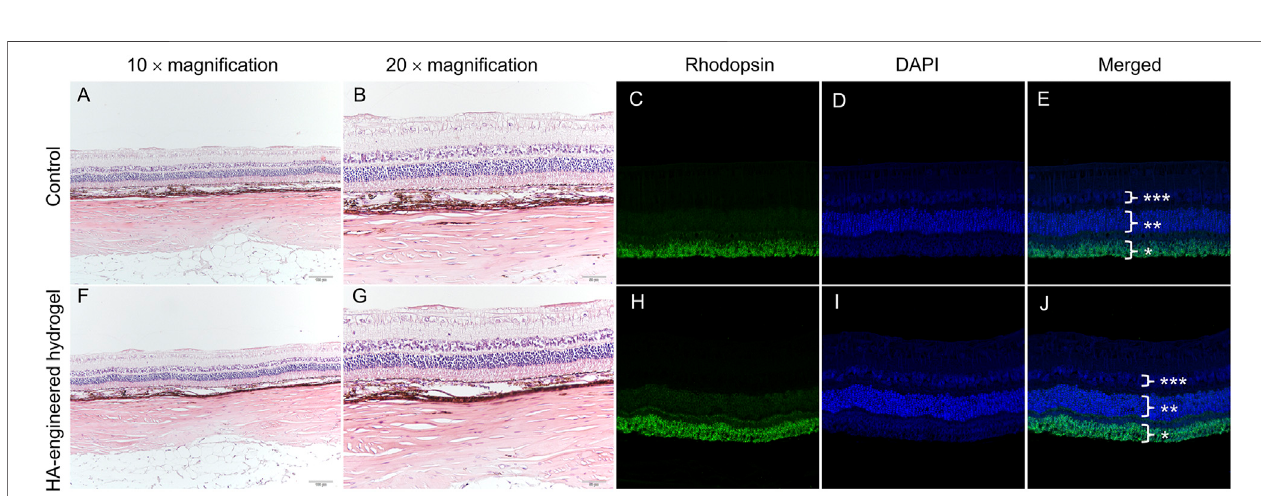
FIGURE 6 | Variation of morphology before and 1 month after the operation in the eye with HA-engineered hydrogel coverage. H&E staining images and immunostaining imagesofthe normal retina (A – E) and theretinawithHA-engineered hydrogel coverage (F – J) .Themagni fi cation ofimmunostainingimages was20×*, rod photoreceptor layers. **, outer nuclear layer; ***, inner nuclear layer. The scale bar for the 10 × magni fi cation was 100 um and that for the 20 × magni fi cation was 50 um.